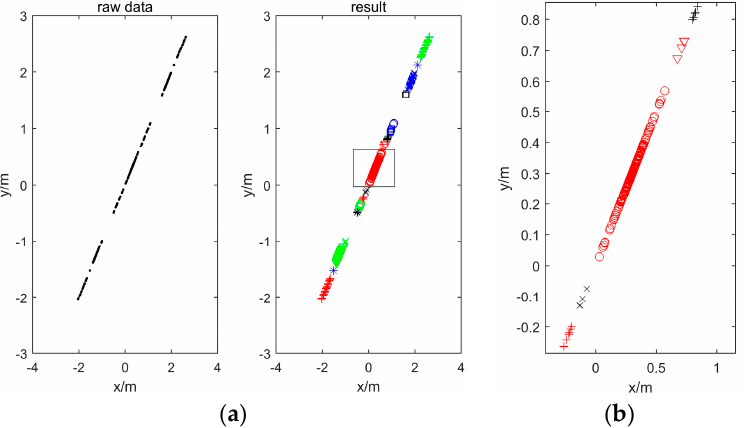
Figure 6. Using DBSCAN to solve rotation angle clustering effect: ( a ) DBSCAN cluster result; ( b ) magnification of result.